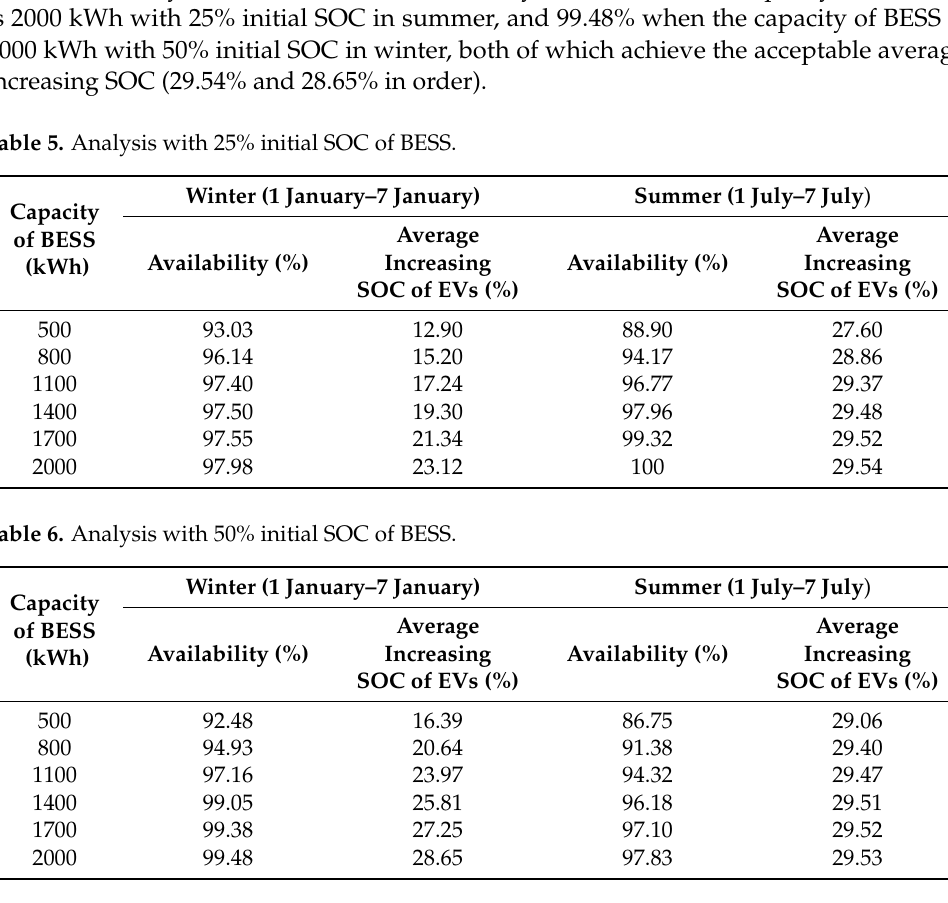
Table 7. Analysis with 75% initial SOC of